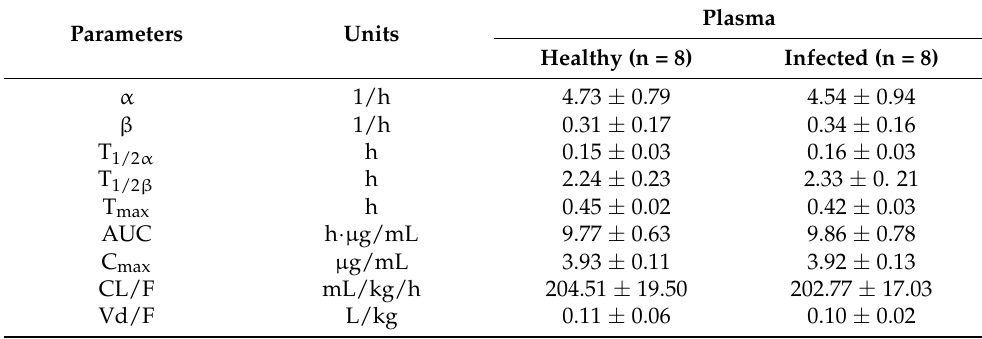
Table 3. Pharmacokinetic parameters of cefquinome in plasma at a dose of 2 mg/kg by intramuscular injection of the pigs (mean ±